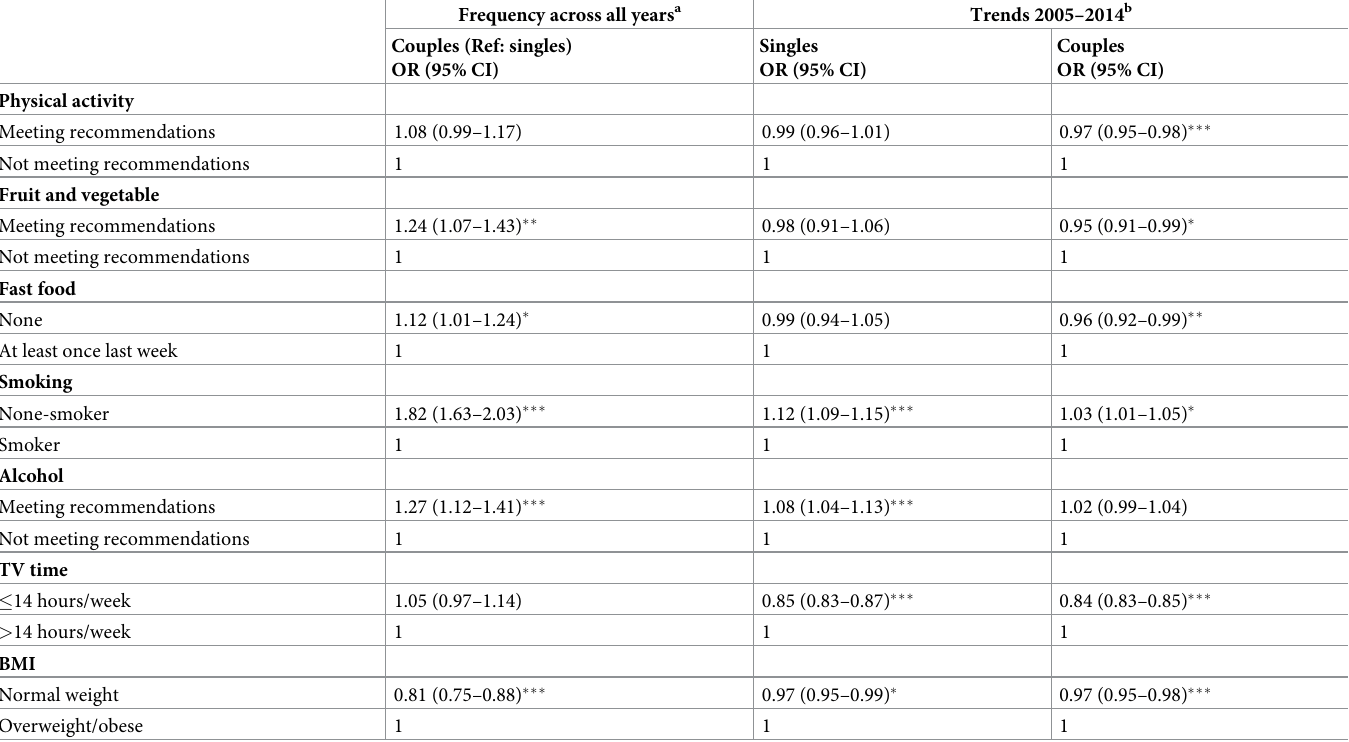
Table 2. Frequency and trends in healthy lifestyle factors by relationship